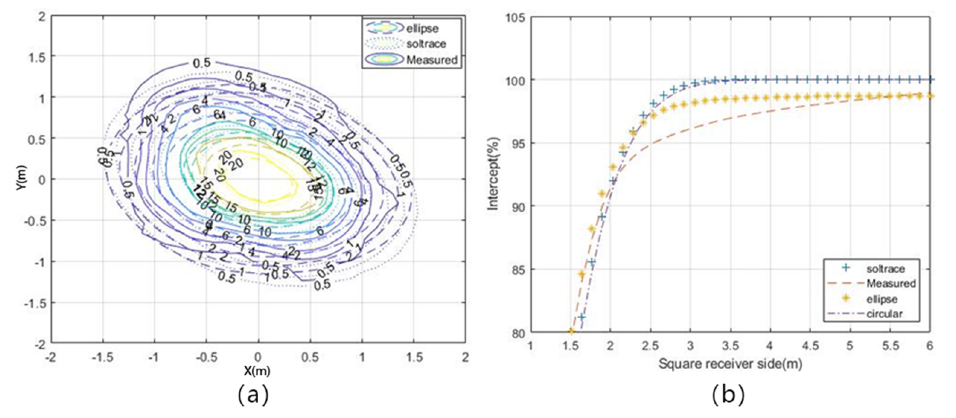
Figure 14. ( a ) Contours of the measured and computed flux distribution (kW/m 2 ): Heliostat #8, ( b ) measured and computed intercepts vs. the side length of a square receiver: Heliostat #8 .